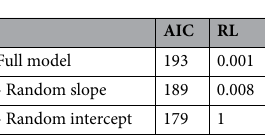
Table 4. Model performance for three versions of a linear mixed model.